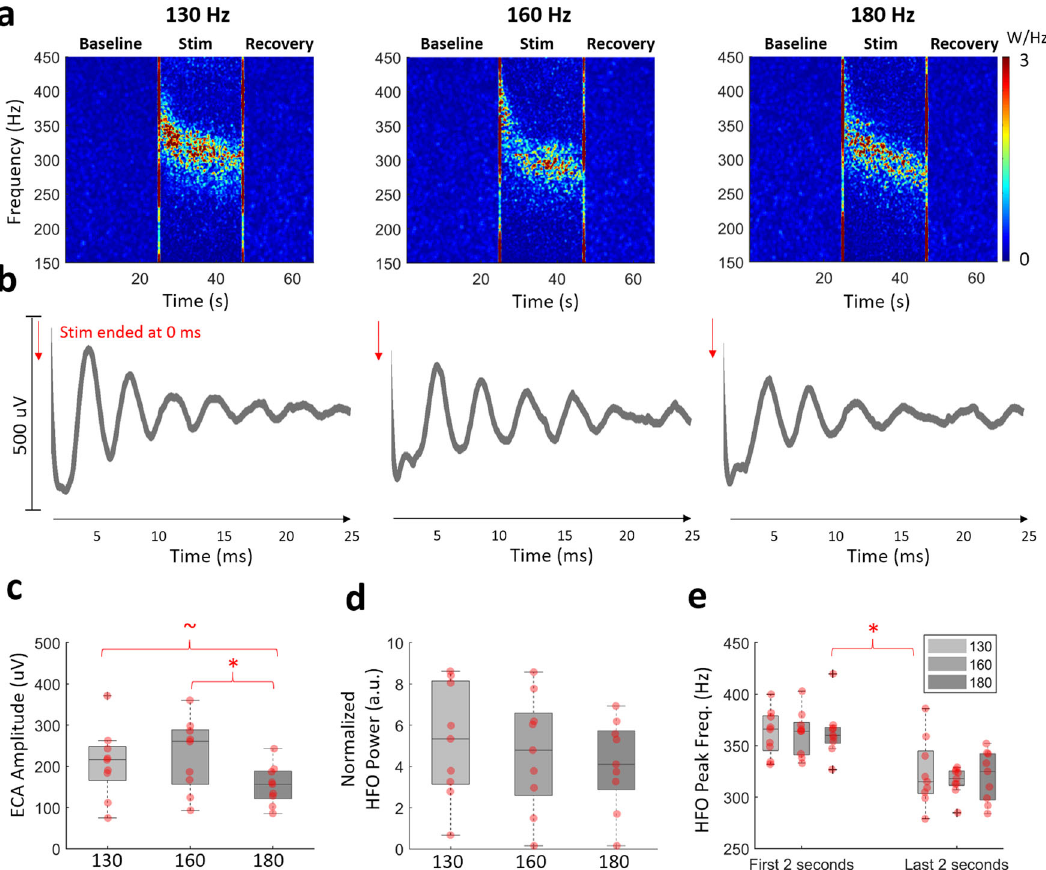
Fig. 5 High-frequency stimulations modulate HFO and ECA in different amplitudes. a The HFO was enhanced with all stimulation frequencies. The large artifacts caused by harmonics of the stimulation frequency are interpolated. The vertical red lines on TFMs are the transition artifacts associated with turning the stimulator on and off. b The ECA waveform after 22 s stimulation period was resonant after all high-frequency stimulations. The fi rst 1 ms after the stimulation pulse is omitted due to large artifact amplitude. c The comparison ECA amplitude after 22 s of stimulation showed that ECA after 180 Hz stimulation was slightly smaller ( n = 9). d The induced HFO bandpowers showed a downward trend as the stimulation frequency increased, but the difference between groups was not signi fi cant. e The peak frequency was signi fi cantly higher in the fi rst two seconds compared to last two, but there was no difference between groups based on stimulation frequency. On each box in the boxplots, the central mark indicates the median, and the bottom and top edges of the box indicate the 25th and 75th percentiles, respectively. The whiskers extend to the most extreme data points not considered outliers, and the outliers are plotted individually using the “ + ” symbol. The individual data points are also plotted as red circles. ~ denotes p value <0.09, * denotes signi fi cance